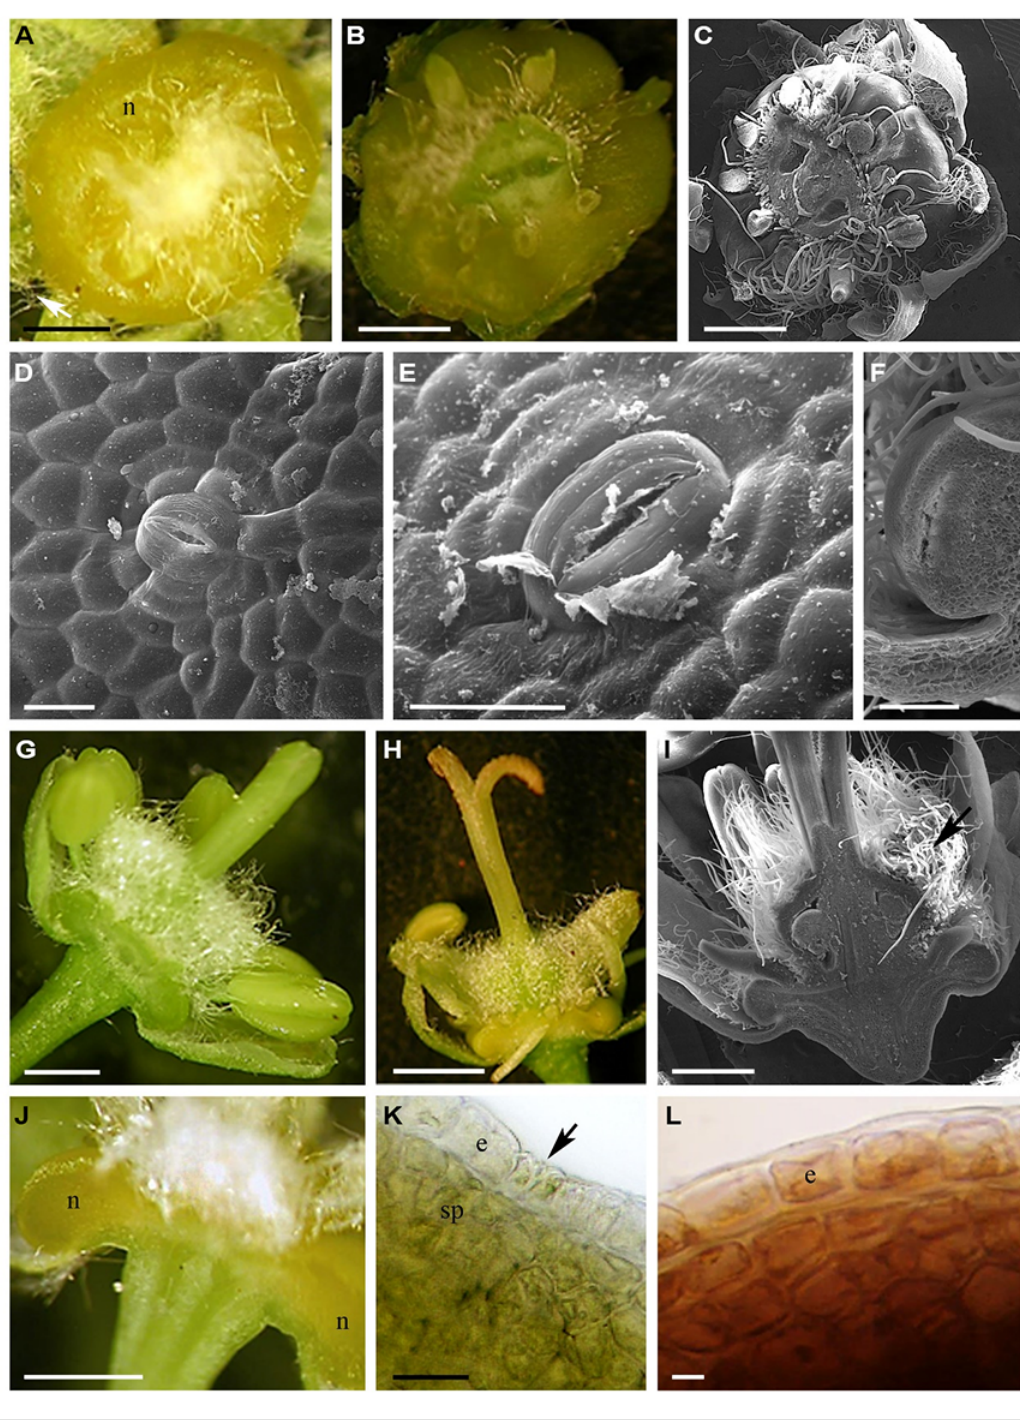
Fig. 2 Fragments of Acer pseudoplatanus flowers with a nectary. ( A ) Nectar layer on the nectary surface, trichomes on the perianth (arrow). ( B ) Top view of the nectary after removal of the stamens and perianth. ( C ) Nectary surface with recesses at the stamens; bar = 1 mm ( A–C ). ( D,E ) Nectary stomata: before the nectar secretion phase ( D ) (bar = 50 μm), during nectar secretion ( E ) (bar = 20 μm). ( F ) Nectary margin in the longitudinal section; bar = 200 μm. ( G ) Green nectary in the bud of a functionally female flower; bar = 2 mm. ( H ) Orange nectary in the stage of the pistil receptivity phase in a functionally female flower; bar = 2 mm. ( I ) Vertical section of a flower with a visible nectary and trichomes on the ovary; bar = 1 mm. ( J ) Yellow-green nectary in the longitudinal section in a functionally male flower; bar = 0.5 mm. ( K ) Longitudinal section of the nectary in a functionally female flower in the bud phase, stomata (arrow); bar = 60 μm. ( L ) Longitudinal section of the nectary in the pistil receptivity phase, visible cell walls of the epidermis and subepidermal parenchyma; bar = 10 μm. n – nectary; e – epidermal cells; sp – subepidermal